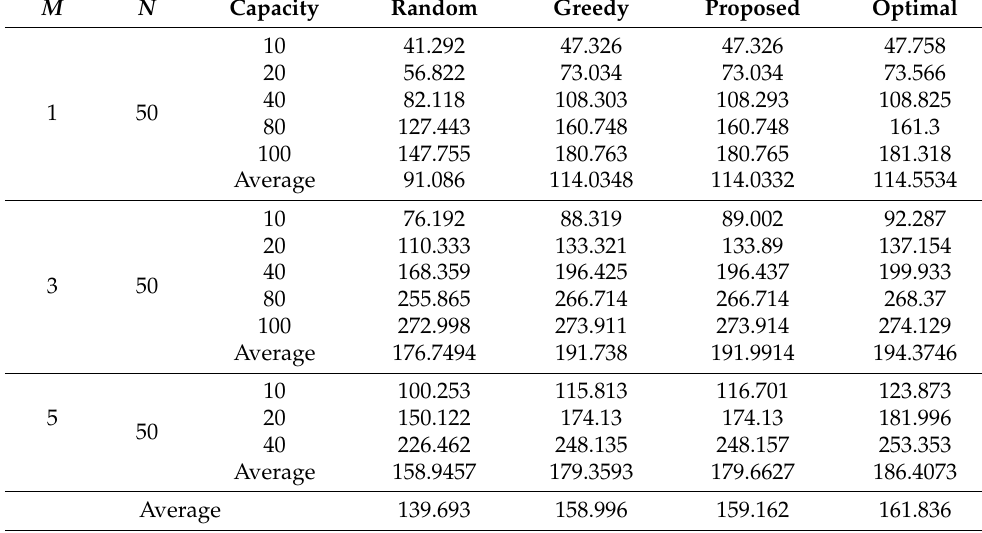
Table 7. Profit of selected items in RI set.